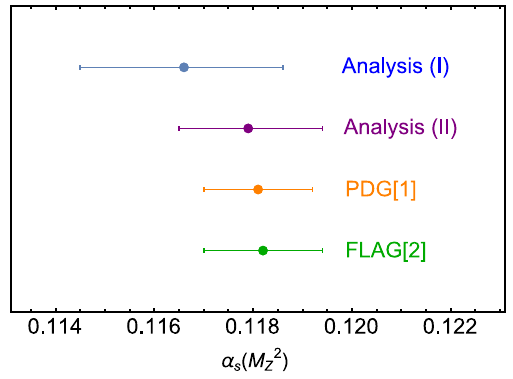
Figure 12 . Comparison of various (cid:11) s